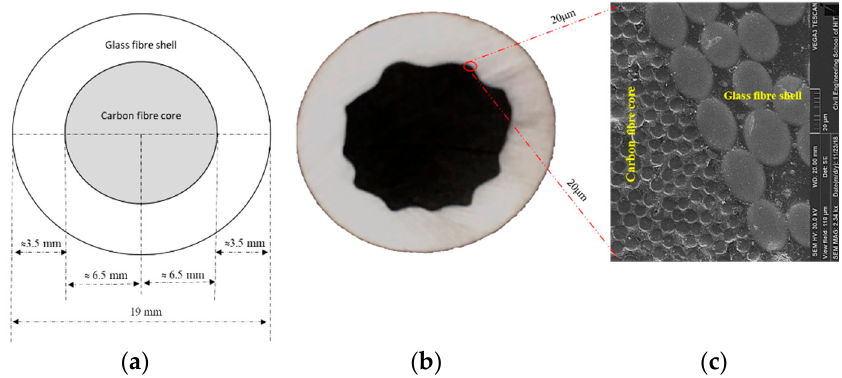
Figure 1. Hybrid fiber-reinforced polymer (HFRP) bar cross-sectional view: ( a ) Diagram representing the cross-sectional dimensions of HFRP bars; ( b ) Cross section of hybrid HFRP bars; ( c ) Enlarged scanning electron microscopic image showing the interface between glass fiber shell/carbon fiber core.